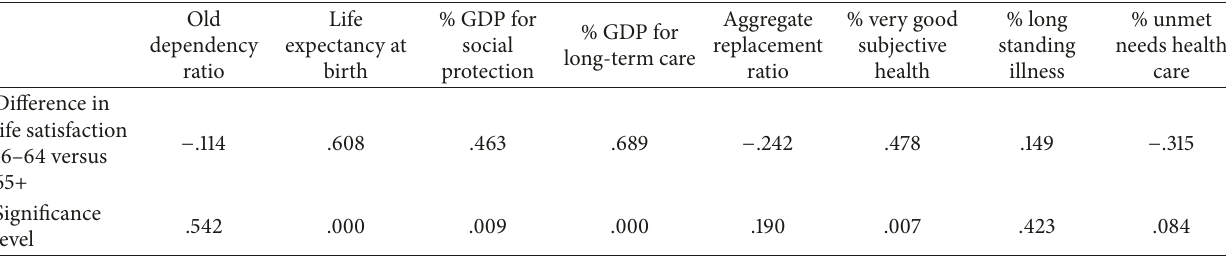
Table 5: Pearson correlations between eight explaining variables and the difference of mean life satisfaction of citizens under 65 years versus over 64 years in